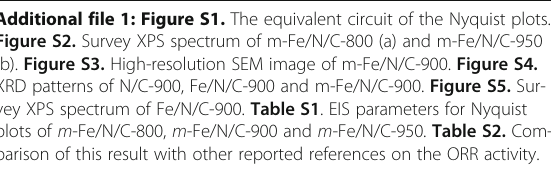
Additional file 1: Figure S1. The equivalent circuit of the Nyquist plots. Figure S2. Survey XPS spectrum of m-Fe/N/C-800 (a) and m-Fe/N/C-950 (b). Figure S3. High-resolution SEM image of m-Fe/N/C-900. Figure S4. XRD patterns of N/C-900, Fe/N/C-900 and m-Fe/N/C-900. Figure S5. Sur- vey XPS spectrum of Fe/N/C-900. Table S1 . EIS parameters for Nyquist plots of m -Fe/N/C-800, m -Fe/N/C-900 and m -Fe/N/C-950. Table S2. Com- parison of this result with other reported references on the ORR